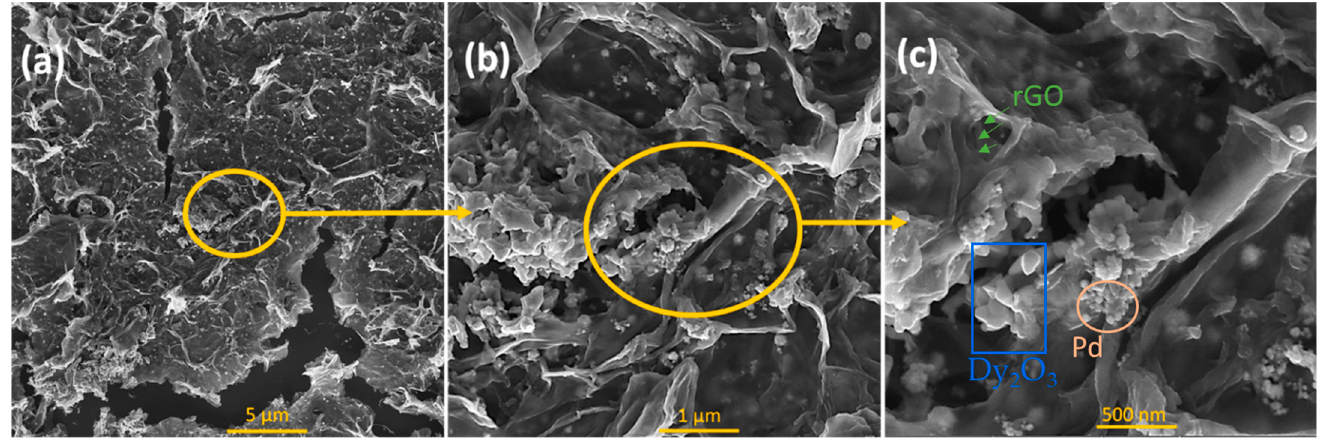
Figure 4. ( a – c ) SEM images of highly porous structure of Dy 2 O 3 -Pd-PDA/rGO nanocomposite with wrinkles and open edges at different magnifications. ( c ) shows the different elements of the nanocomposite.